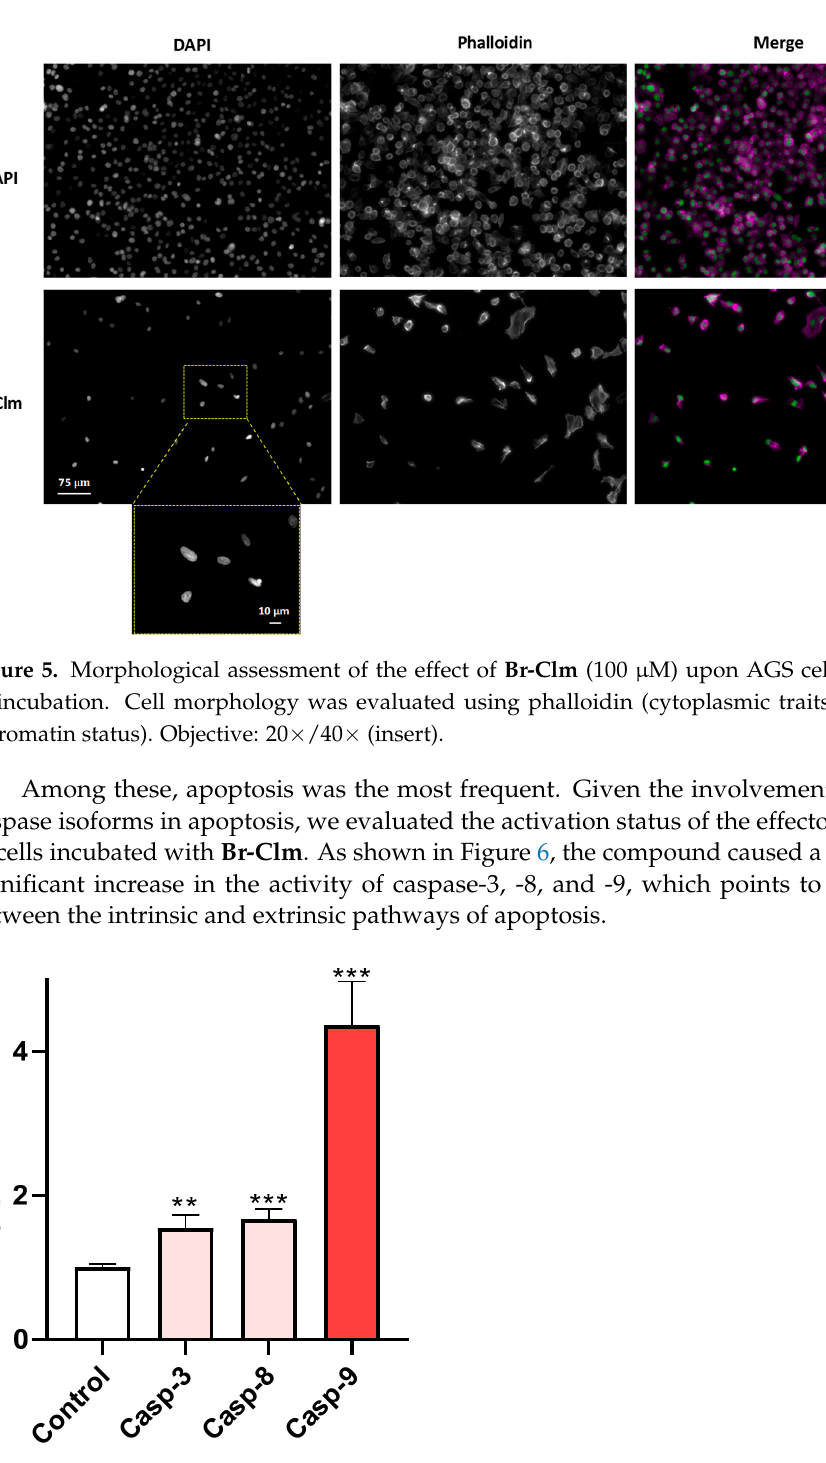
Figure 6. Activity of caspase-3/8/9 in AGS cells after incubation with Br-Clm (100 µ M) for 24 h when compared to basal levels. ** p < 0.01, *** p < 0.001.